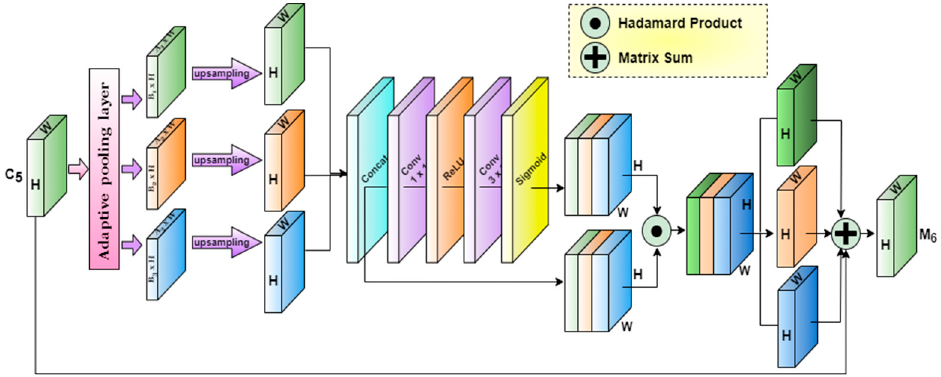
Figure 7. Proposed attention module with adaptive